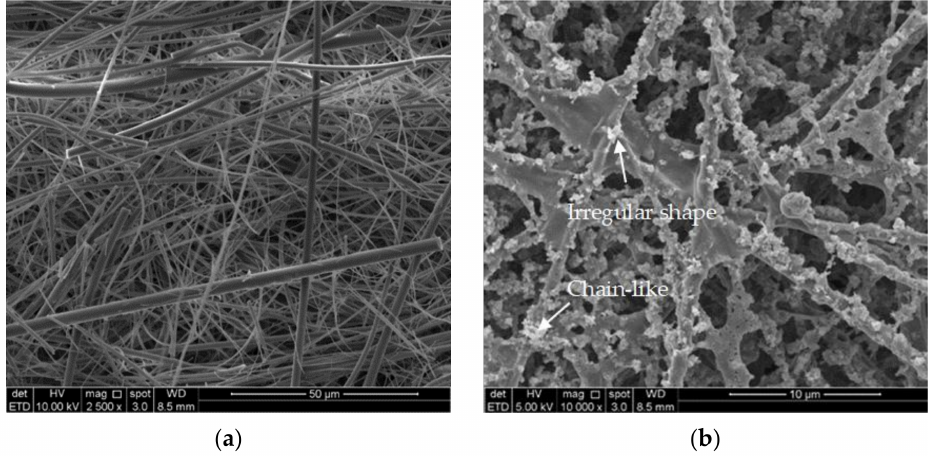
Figure 7. Micrograph of ( a ) blank glass-fiber filter paper and ( b ) glass-fiber filter paper spots that contained PM 2.5